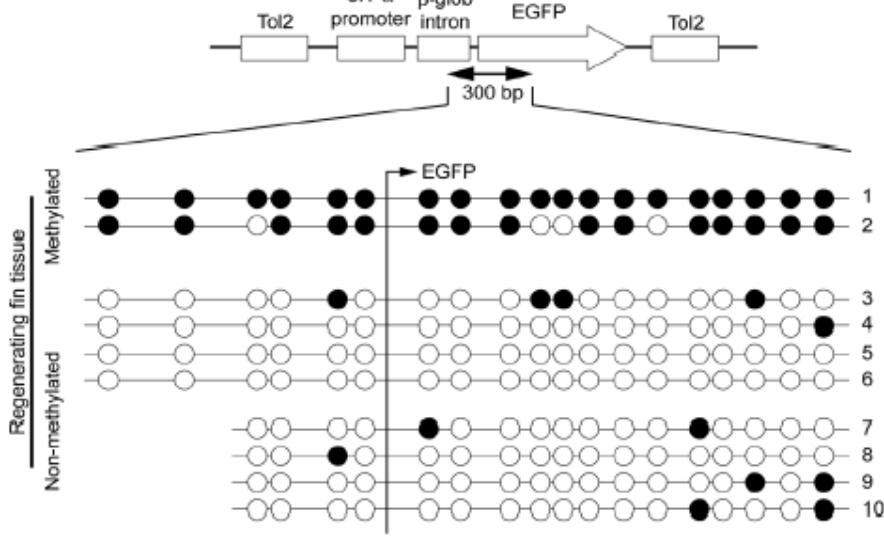
FIGURE 7. The regenerating caudal fin contains both methylated and unmethylated states of the ef1-a:EGFP transgene. Methylation pattern of a region of the ef1-a:EGFP transgene during fin regeneration. A schematic of the ef1-a:EGFP transgene in the Tol2 pT2KXIG element is shown above, with the region of the EGFP reporter gene that was analyzed shown below. DNA samples were obtained from the regenerative tissue of a 4-dpa fin. Two different primer sets were used to amplify an approximately 300-bp region surrounding the EGFP translational start site (marked by an arrow). Each line represents a different PCR subclone; subclones 1–6 were obtained using primer set 1 and clones 7–10 using primer set 2. The state of methylation of each subclone was analyzed using bisulfite conversion of nonmethylated cytosines to uracils and DNA sequencing. Each of the 19 CpG methylation sites in the first primer set region and 17 CpG sites in the second primer set region is represented by a small circle. Notice that both primer sets examine 17 common CpG sites. Empty circles indicate an absence of methylation, while closed circles indicate that the CpG sequence was methylated. Note